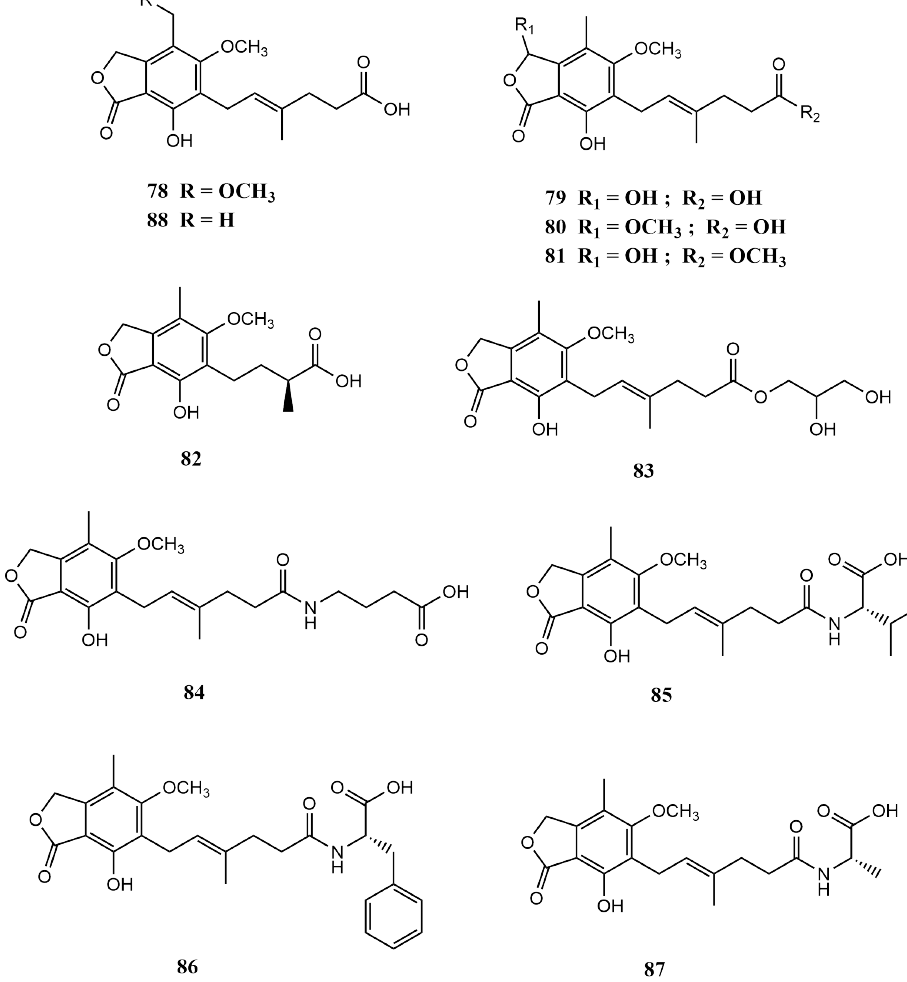
Figure 9. Additional metabolites ( 78 – 88 ) from the soft-coral Sarcophyton -derived marine fungi ( cont. ). 8- O -methyl mycophenolic acid ( 78 ), 3-hydroxy mycophenolic acid ( 79 ) and MPA ( 88 ), being white crystals, are part of the mycophenolic acid family where they are mainly found in the fungal genus Penicillium . They are widely known for their diverse bioactivities, such as immunosuppressive and antiviral. Compounds ( 80 – 84 ) were newly characterised at the time of isolation. Compounds ( 80 – 81 ) were isolated as white powders [100]. Based on structural elucidation, compound ( 80 ) was named 6-(5-carboxy-3-methylpent-2-enyl)- 7-hydroxy-3,5-dimethoxy-4-methylphthalan-1-one, while compound ( 81 ) was determined as 6-(5-methoxycarbonyl-3-methylpent-2-enyl)-3,7-dihydroxy-5-methoxy-4-methylphthalan-1- one [100]. 3-hydroxy mycophenolic acid ( 79 ) and compound ( 80 ) share identical structures, except that the hydroxyl group at C-3 of ( 79 ) is replaced by a methoxy in compound ( 80 ). Comparison between compounds ( 80 ) and ( 81 ) shows that the carboxyl group at C-6 (cid:48)